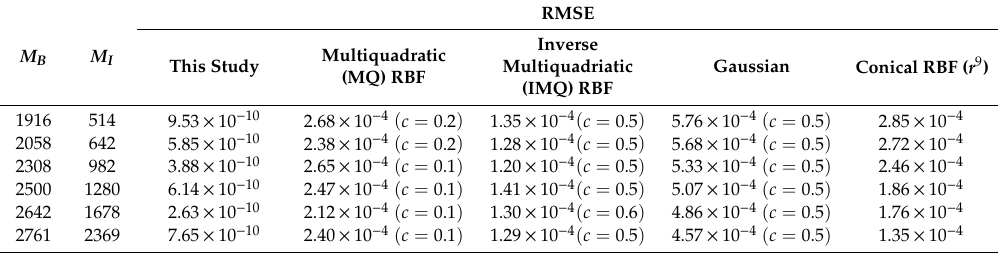
Figure 4. Dilation parameter versus RMSE. Table 1. Root mean square errors (RMSEs) of the proposed approach and other radial basis functions (RBFs).